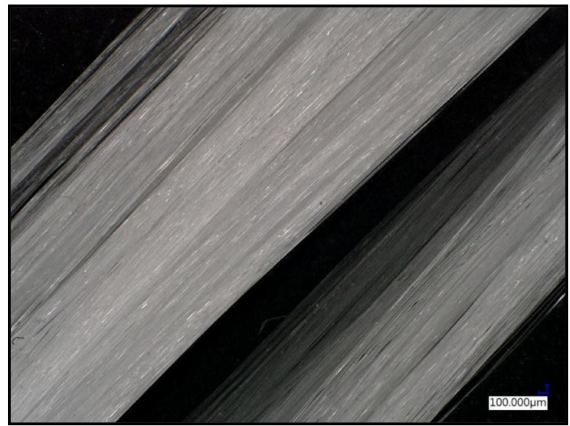
Figure 2. A micrograph of R-glass fibre bundles taken with a digital microscope, the Keyence VHX6000 (Osaka,